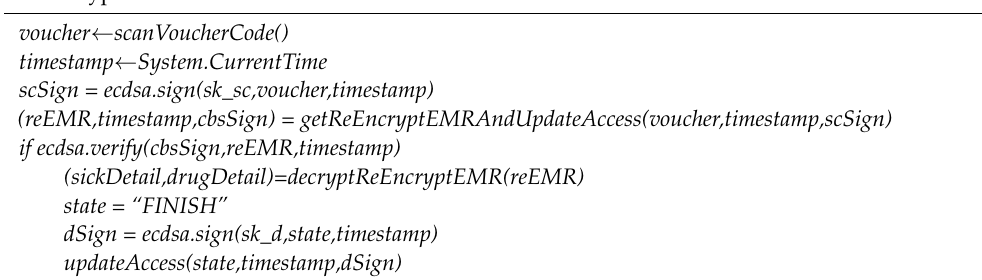
Algorithm 6. The chaincode of the pseudo-code of scanning of access voucher and acquisition of re-encrypted